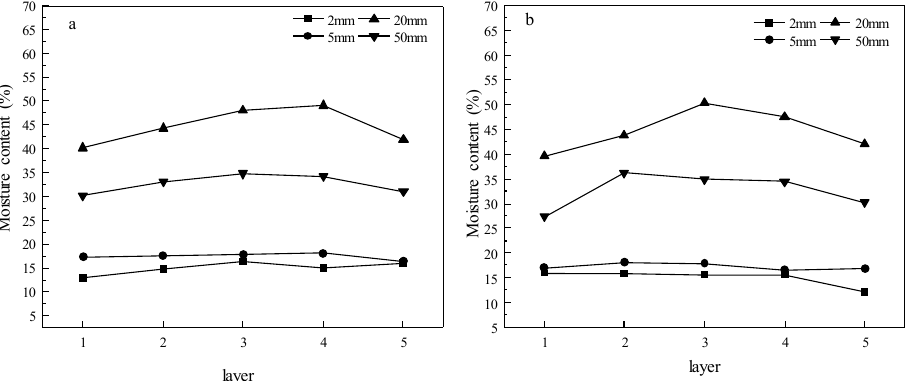
Figure 4. Three-dimensional moisture distributions of specimens with lengths of 2, 5, 20, and 50 mm after the 12th dewatering cycles.